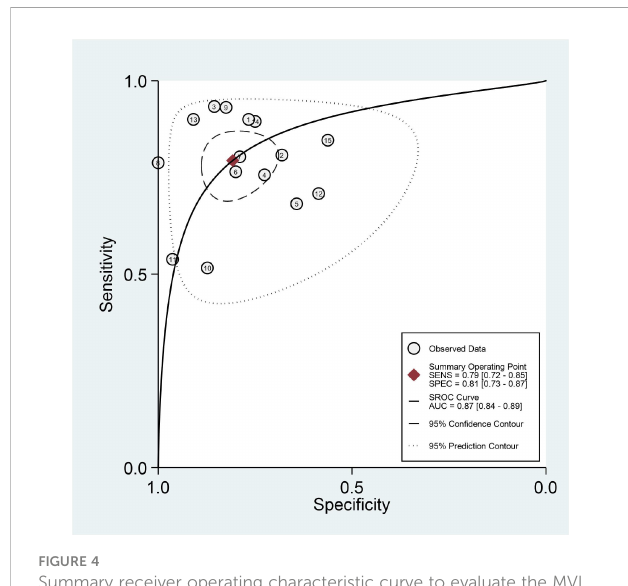
FIGURE 4 Summary receiver operating characteristic curve to evaluate the MVI of